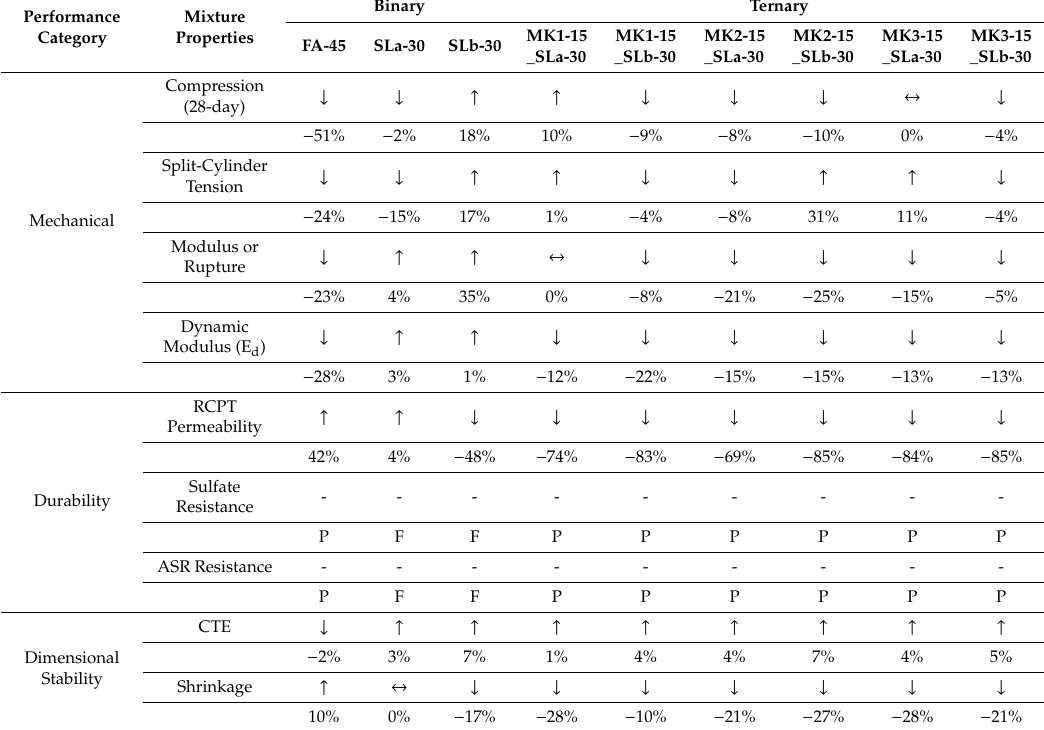
Table 4. Summary of alternate binary and ternary mixture performance compared to control (% change). Note: The up and down arrows indicate increases and decreases, respectively; arrows on both sides indicate insignificant change; and Pass (P) / Fail